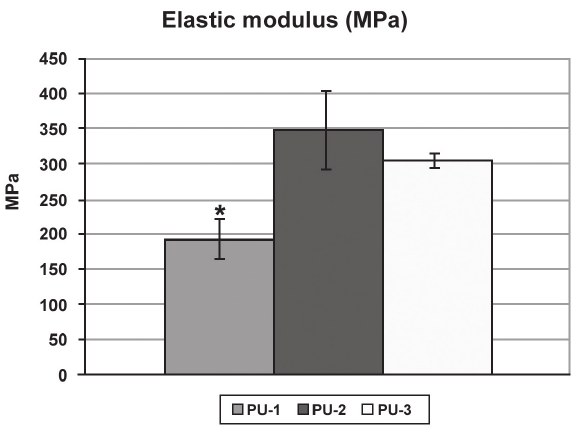
Figure 3- Modulus of elasticity means values (MPa) according to mixture concentration. Bars represent standard deviation. *p<0.05 as compared to groups 2 and 3.